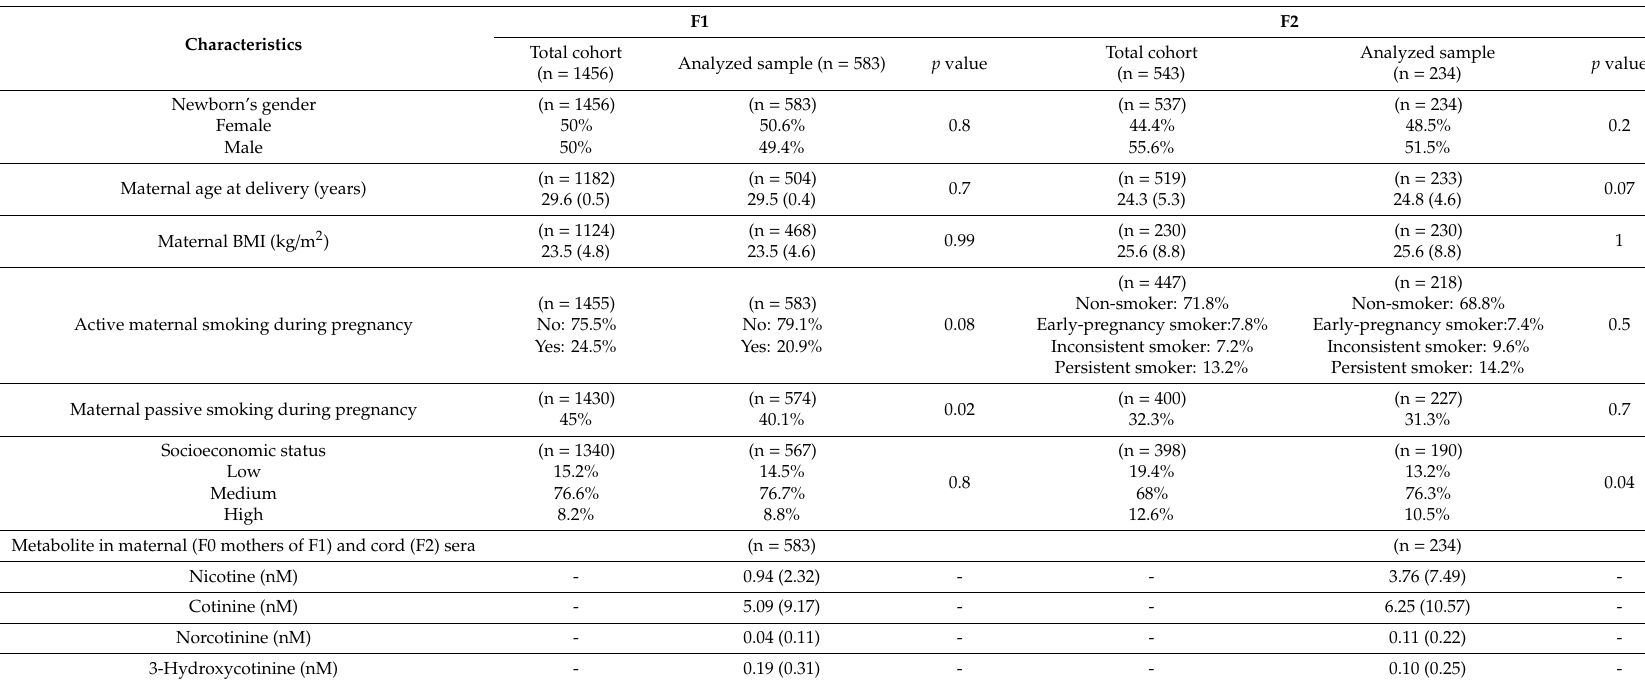
Table 1. Characteristics of study participants from the Isle of Wight cohort (F1 and F2 generations); comparison of total cohort with participants where samples were analyzed for nicotine metabolites in maternal (F0 mothers of F1) and cord (F2)